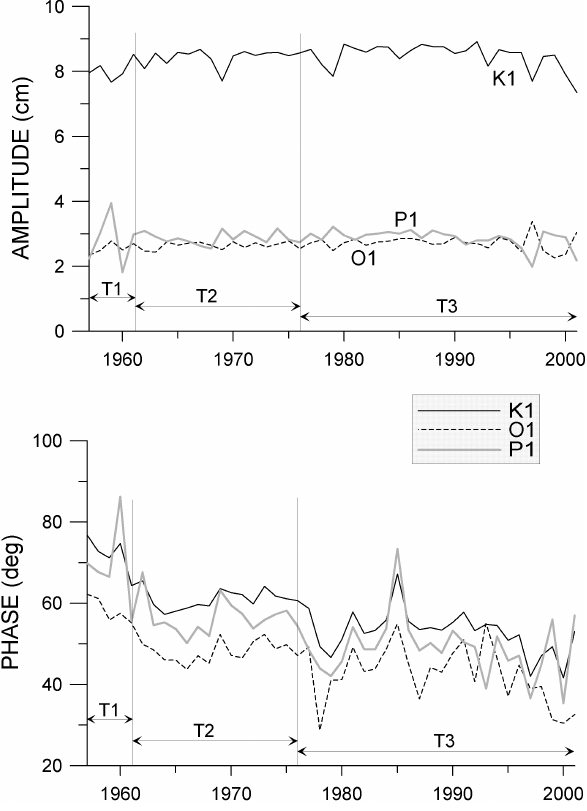
Fig. 3. Annual amplitudes and phases of semidiurnal constituents calculated for Split in 1957–2001